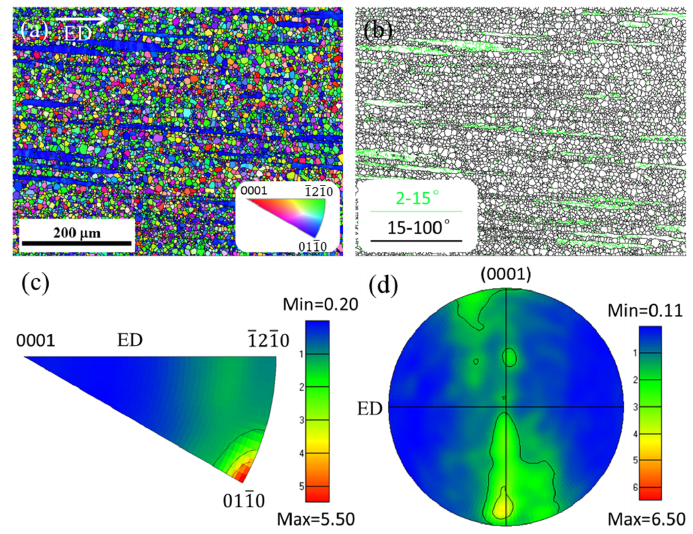
Figure 5. Inverse pole figure (IPF) map ( a ) of the as-extruded Ex-1 WE43 alloy along with its corresponding ( b ) boundary map, ( c ) typical IPF, and ( d ) (0001) basal pole figure (PF). The extrusion direction (ED) is horizontal in picture ( a ).